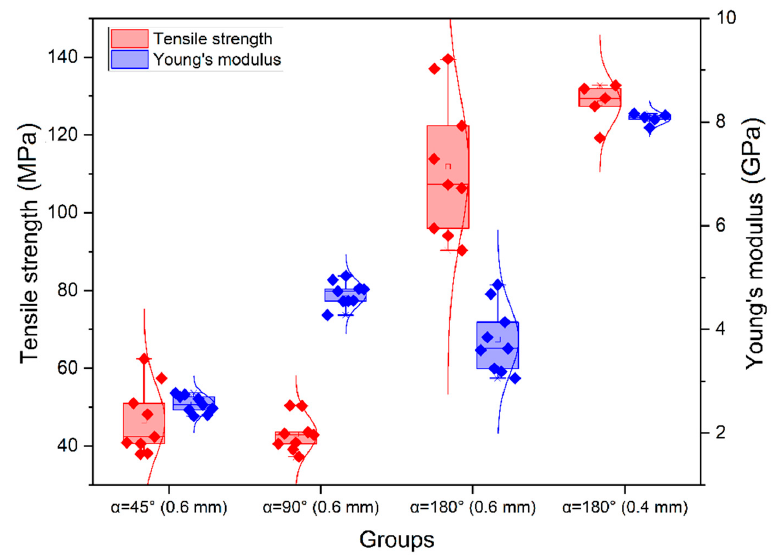
Figure 8. Results for tensile strength and elastic modulus of heat-treated samples for α = 45°, α = 90° and α = 180°.